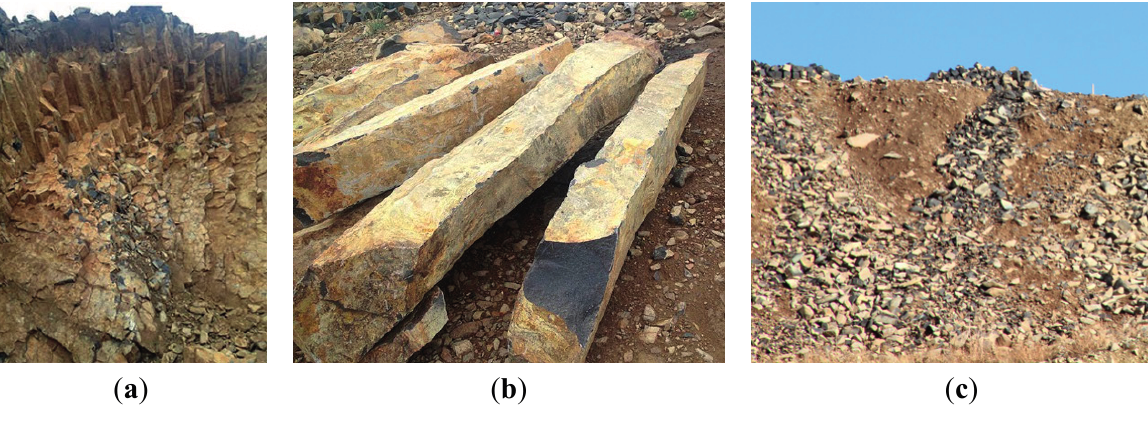
Figure 2. ( a ) Basalt reserve; ( b ) altered basalt columns (yellow to orange